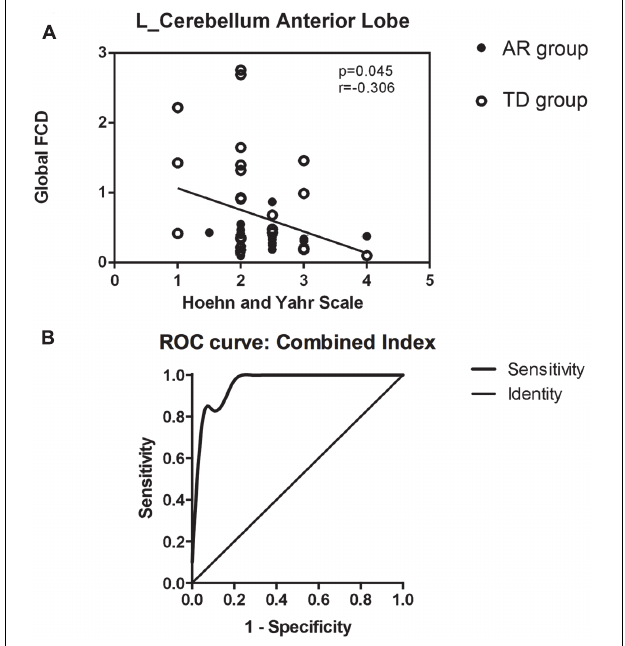
FIGURE 3 | (A) Show the correlations between regions with altered global FCD and clinical data in PD group (TDs and ARs) (spearman rank correlation analyses, p < 0.05). (B) Shows receiver operating characteristic (ROC) curve of the combination of the four FCD indexes for distinguishing PD subtypes